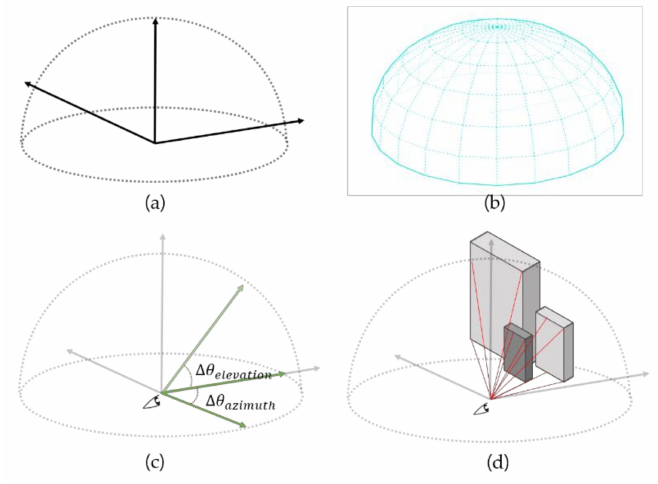
Figure 1. Visible space for a stationary state. ( a ) Human field of view at standstill; ( b ) splitting the visual field based on the unit line of sight; ( c ) line of sight variables; ( d ) recognition of an object with the line of sight method in the visual